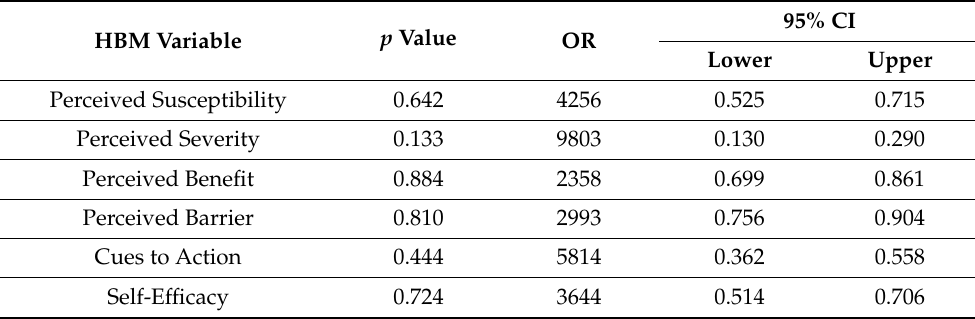
Table 12. Association between health belief and nutritional